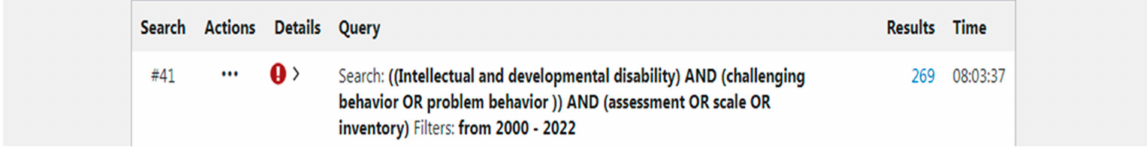
Figure A1. Search Strategy through Electronic